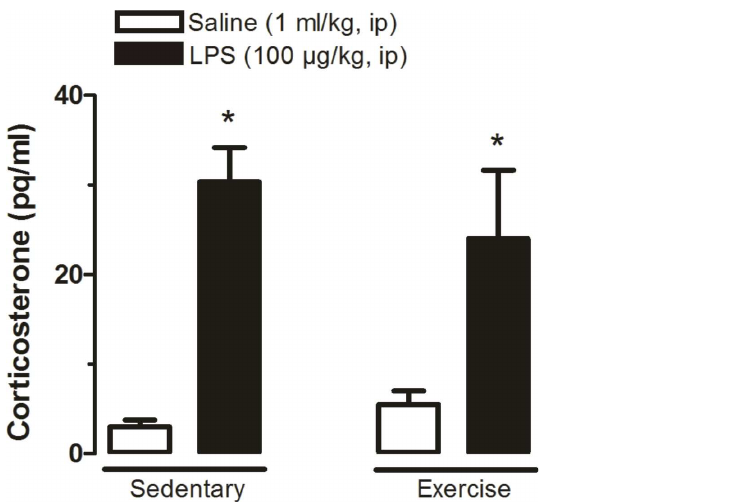
Fig 6. Plasma corticosterone levels at 120 min after systemic administration of LPS or saline. Sedentary saline (n = 8), Sedentary LPS (n = 6), Exercisedsaline (n = 5) and ExercisedLPS (n = 5). * P < 0.05, Groups treated with LPS vs. the respectivecontrol group.